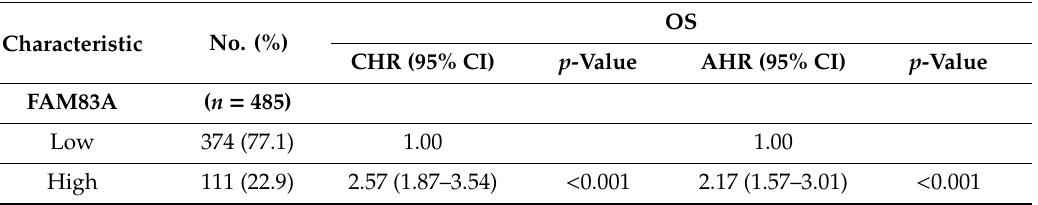
Table 3. Univariate and multivariate Cox’s regression analysis of gene expression for overall survival of 485 patients with lung cancer.